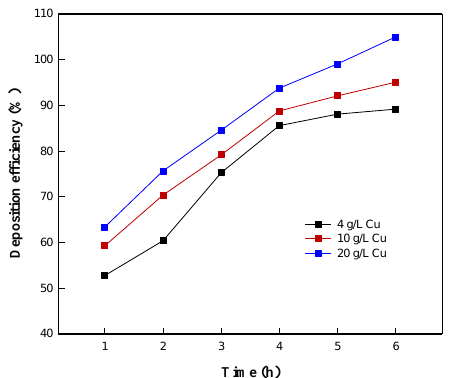
Figure 8. Effect of total Cu concentration on Cu deposition efficiency. Electrodeposition conditions: H 2 SO 4 100 g/L, total Cu 4.0 − 20.0 g/L, current density 15 mA/cm 2 , 1–6 h, 45 ◦ C.